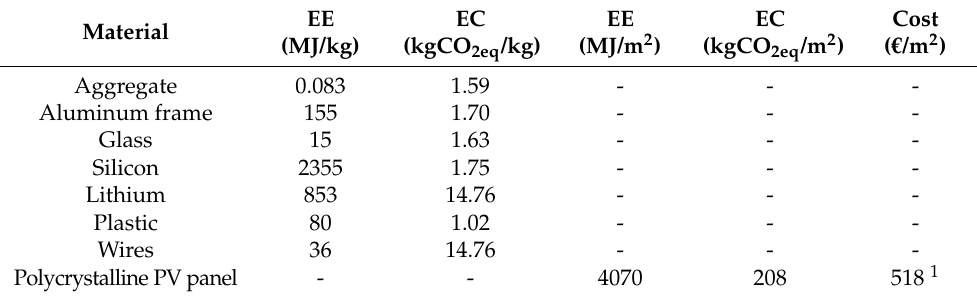
Table 7. Embodied Energy (EE), Embodied Carbon (EC), and Cost of PV panel